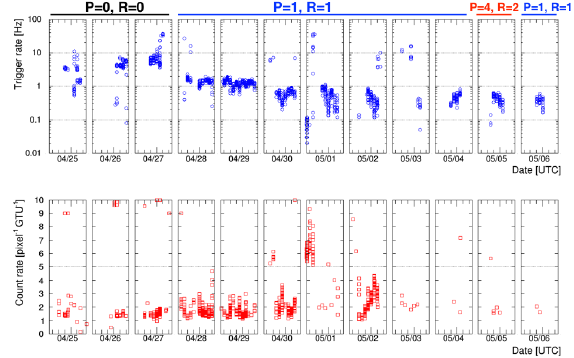
Figure 7. Trigger rate (top) and average count rate measured at pixel level (bottom) measured by EUSO-SPB in